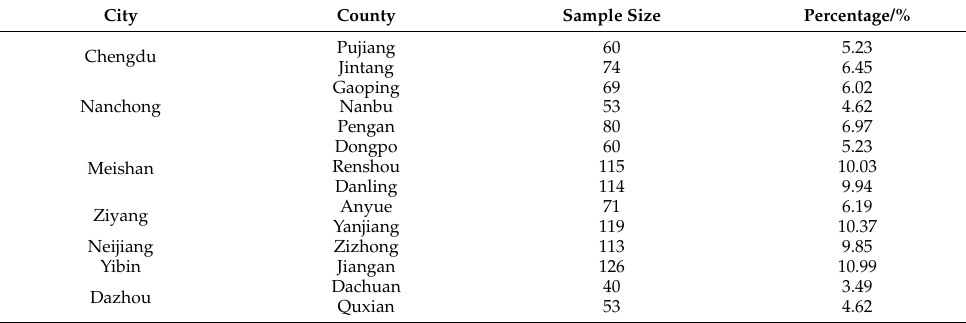
Table 1. Sample size